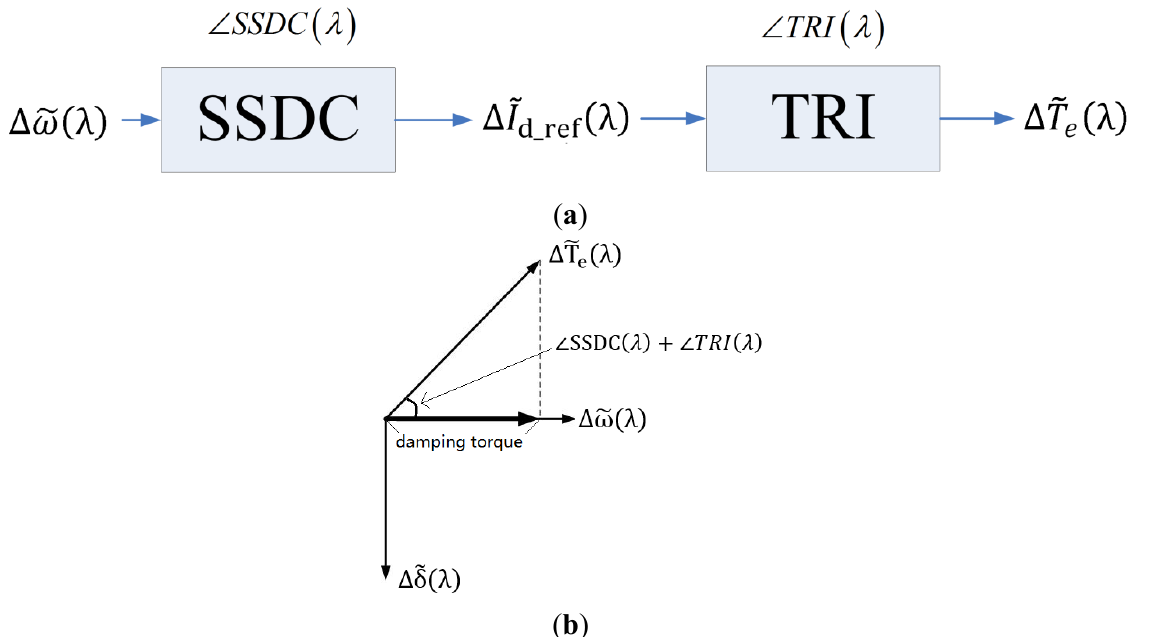
Figure 1. Phase relationship of key variables in SSDC design: ( a ) transfer scheme; ( b ) phasor diagram.